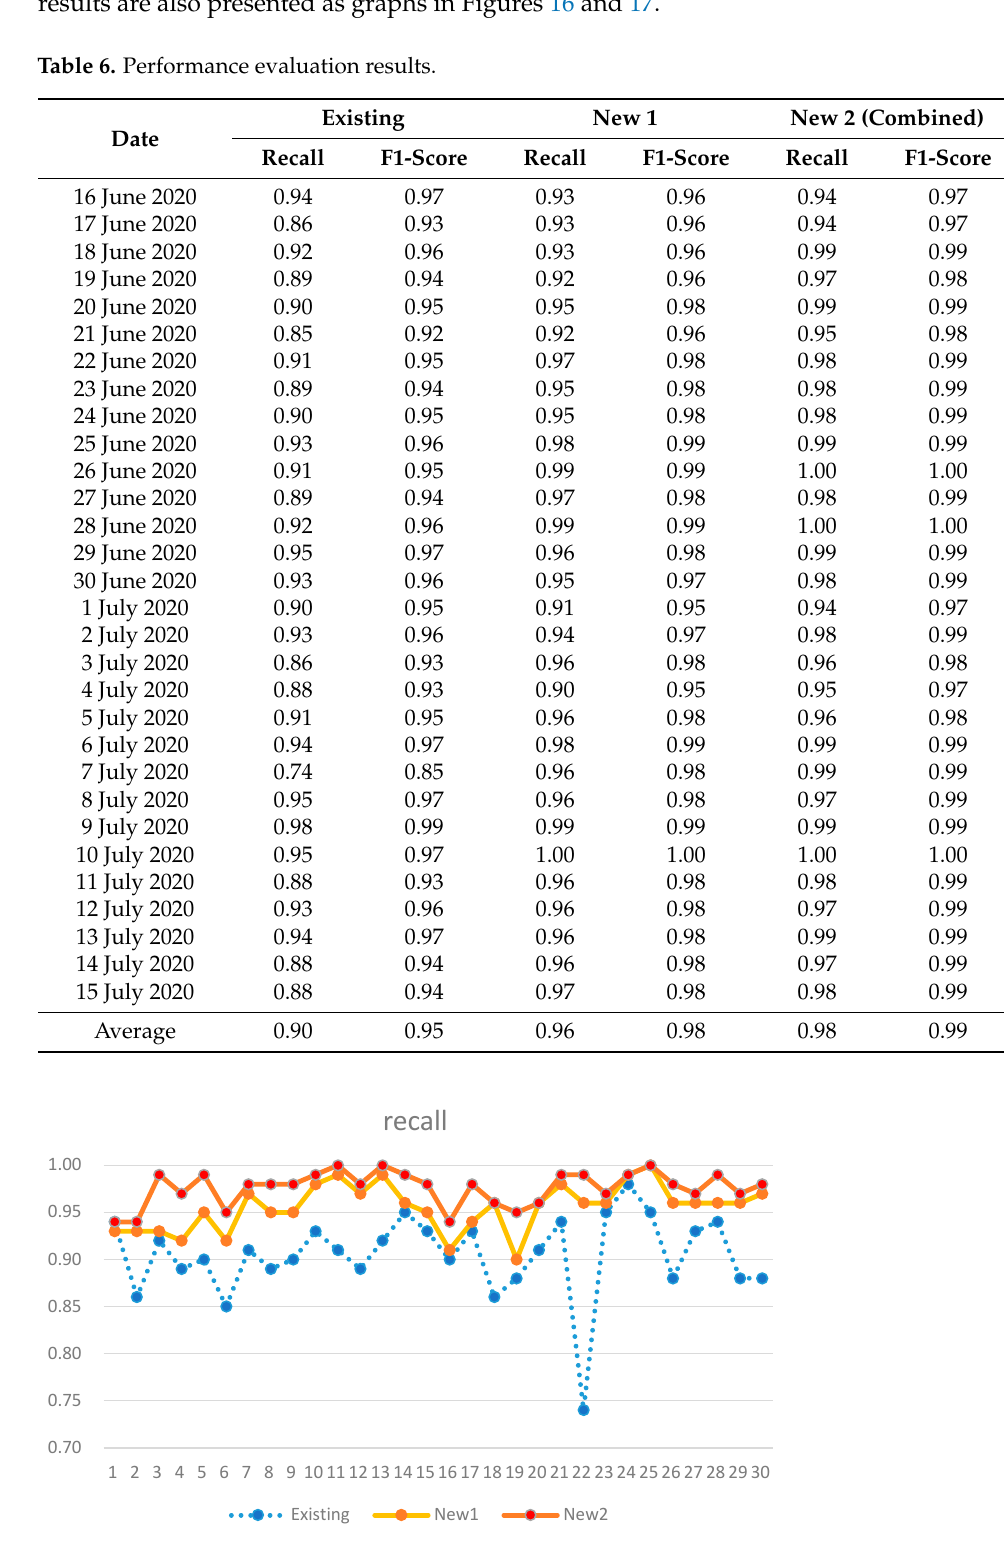
Figure 17. Performance comparison in f1-score metric. 4.4. Discussion We know the actual positive cases, so TP and FN in the confusion matrix are the most obvious values. Therefore, among all the performance metrics, recall, which is composed of only TP and FN, is a more reliable performance metric. When interpreting the results, recall is considered the most important metric for our purposes. A recall performance close to 1 indicates that unnecessary work is significantly reduced. The possibility of false alarms is 10% in the existing systems. The ratio is sometimes burdensome to the service provider, so improvement is expected.